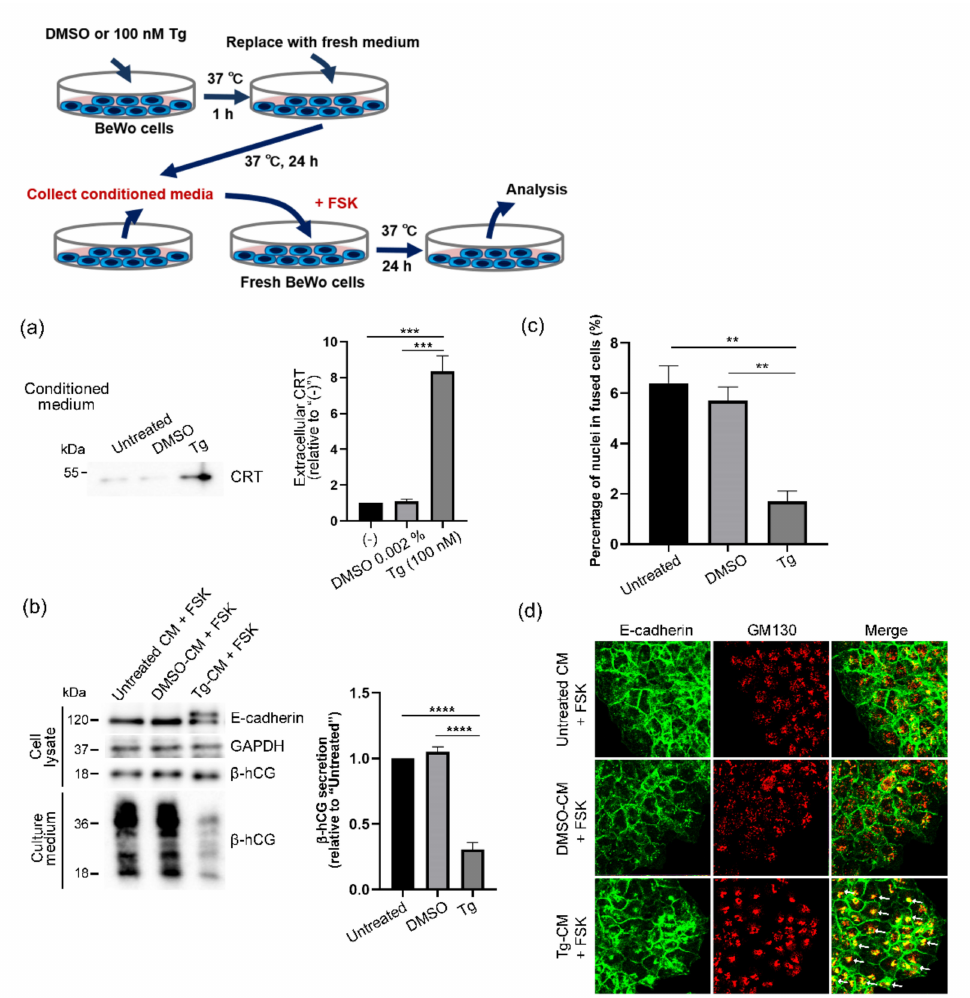
Figure 4. Extracellular CRT-induced inhibition of forskolin-induced syncytialization in BeWo cells. ( a ) BeWo cells were treated with thapsigargin (Tg) or DMSO for 1 h at 37 ◦ C. After samples were washed three times with PBS, culture media were replaced with fresh Opti-MEM and cells were cultured for 24 h at 37 ◦ C. Conditioned medium samples were then collected to obtain DMSO-CM and Tg-CM. Extracellular release of CRT by thapsigargin was confirmed by means of Western blotting. The graph shows quantification of extracellular release of CRT by Tg (100 nM)-treatment. Data represent means ± SE (n = 3). ( b ) To investigate the effects of extracellular CRT on syncytialization, fresh BeWo cells were treated with DMSO-CM or Tg-CM in the presence of forskolin (FSK, 80 µ M) for 24 h at 37 ◦ C, and expression of E-cadherin and secretion of β -hCG were analyzed by using Western blotting. GAPDH served as the loading control. The graph shows quantification of secreted β -hCG. Data represent means ± SE (n = 3). ( c ) Effects of Tg-CM treatment on syncytialization was analyzed by means of fusion indexes. Data represent means ± SE (n = 3). ( d ) Effects of Tg-CM treatment on subcellular localization of E-cadherin were analyzed by means of immunofluorescence with anti-E-cadherin and anti-GM130 antibodies. Arrows point to condensed E-cadherin signals that colocalized with GM130. ** p < 0.01; *** p < 0.001; **** p <